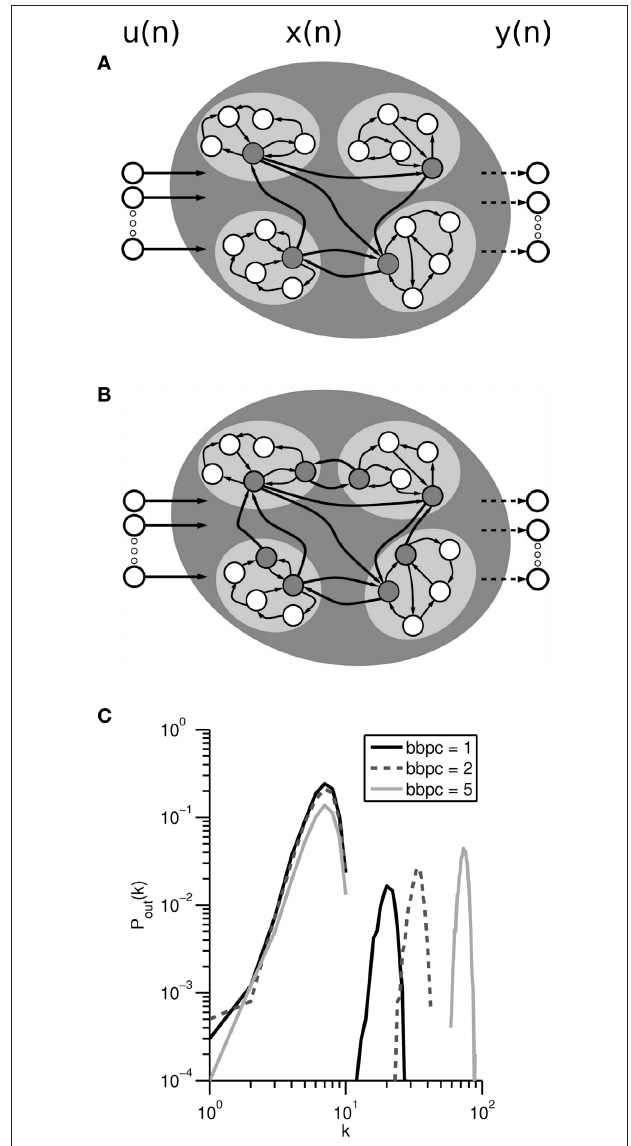
Figure 1 | (A) Example of a HESN network with four clusters (light gray). Each cluster contains four local units (white circles) that only project within the cluster and one backbone unit (dark gray circles) that provide connections between clusters. Dashed lines indicate trainable weights. Each unit has a sigmoidal transfer function, bounded on [ − 1, 1]. (B) Non-hierarchical HESN with similar topology and two backbone units per cluster. By increasing the number of backbone units per cluster, the HESN becomes non-hierarchical and increasingly more homogeneous. (C) Average out-degree distribution P ( k ) for HESN with arbitrary configuration (200 units, 20 clusters, out conn = conn = 0.7) against different values for backbone unit per cluster inter intra ( bbpc ), calculated over 50 independent realizations of reservoir. The connectivity does not follow a power law distribution and so is not scale-free, unlike the original SHESN